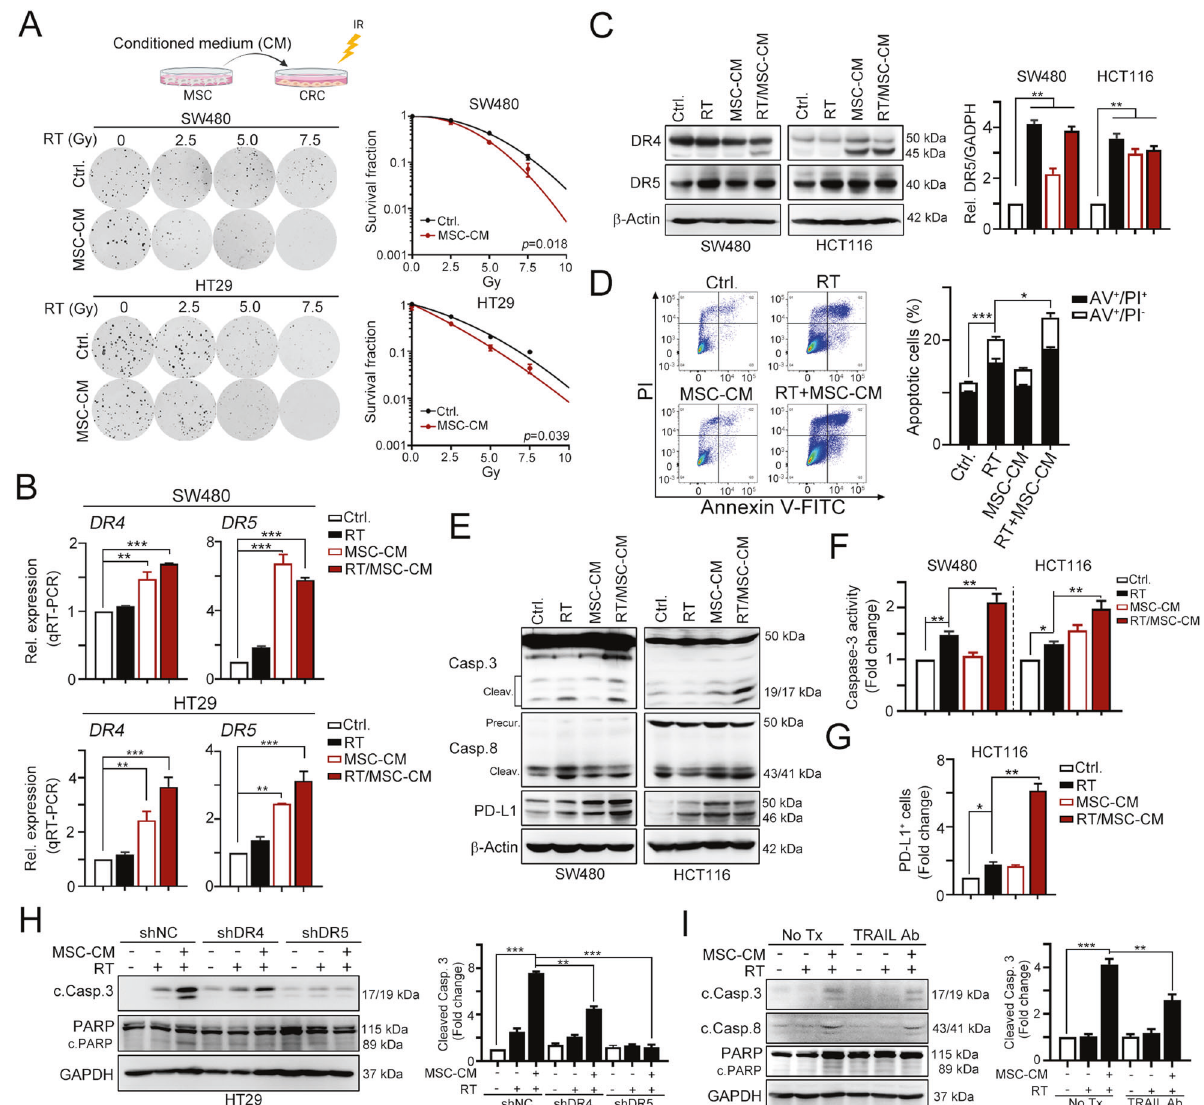
Fig. 3 Type I IFN signi fi cantly enhanced radiotherapy-induced cell death by TRAIL signaling in cGAS-de fi cient CRC cells. A SW480 and HT29 cells were treated with conditioned medium (CM) from MSCs and RT (5 Gy). After 7 days, the survival fraction was examined by clonogenic assay. B SW480 (cGAS-de fi cient) and HT29 (cGAS/STING-pro fi cient) cells were treated with MSC-CM and RT (5 Gy) for 24 h. The mRNA level of DR4 and DR5 was evaluated by qRT-PCR (mean ± SEM, n = 3). ** p < 0.01 and *** p < 0.001. C SW480 and HT29 were treated with MSC-CM and RT (5 Gy) for 24 h. The level of DR4 and DR5 was evaluated by western blot (mean ± SEM, n = 3). ** p < 0.01 and *** p < 0.001. D SW480 cells were treated with MSC-CM and RT (5 Gy) for 24 h. The apoptosis rate was examined by Annexin V-FITC/PI assay (mean ± SEM, n = 3). * p < 0.05 and *** p < 0.001. E SW480 and HCT116 cells were treated with MSC-CM and RT (5 Gy) for 24 h. The level of caspase-3 and PARP cleavage was evaluated by western blot. F SW480 and HCT116 cells were treated with MSC-CM and RT (5 Gy) for 24 h. The activity of caspase-3 was evaluated by a caspase-3 activity assay kit (mean ± SEM, n = 3). ** p < 0.01. G HCT116 cells were treated with MSC-CM and RT (5 Gy). The tumor surface PD-L1 was analyzed by fl ow cytometry. H HT29 shNC , HT29 shDR4 , and HT29 shDR5 cells were treated with MSC-CM and RT (5 Gy). The level of caspase-3 and PARP cleavage was evaluated by western blot. I HT29 cells were treated with TRAIL neutralizing antibodies (1 μ g/mL), MSC-CM and RT (5 Gy). The level of caspase-3 and PARP cleavage was evaluated by western